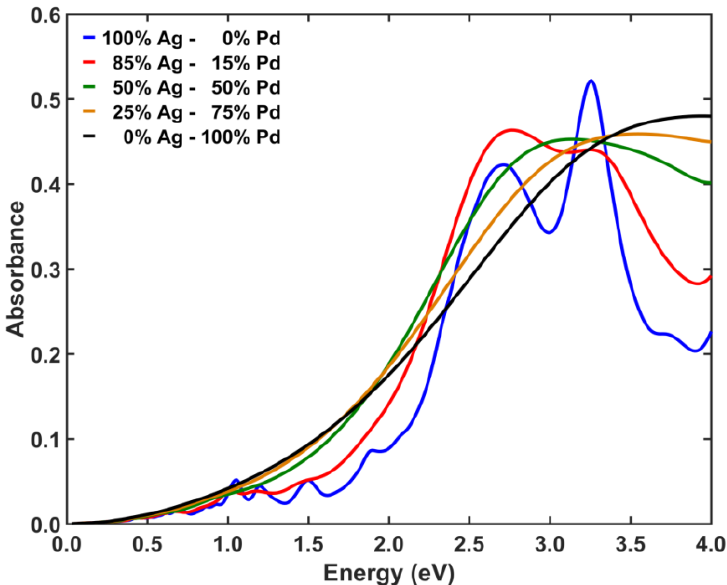
Figure 7. Different syntheses of the AgPd alloy reflecting the existence of LSPRs. The parameters are: d = 100 nm, a = 200 nm, t = 50 nm.